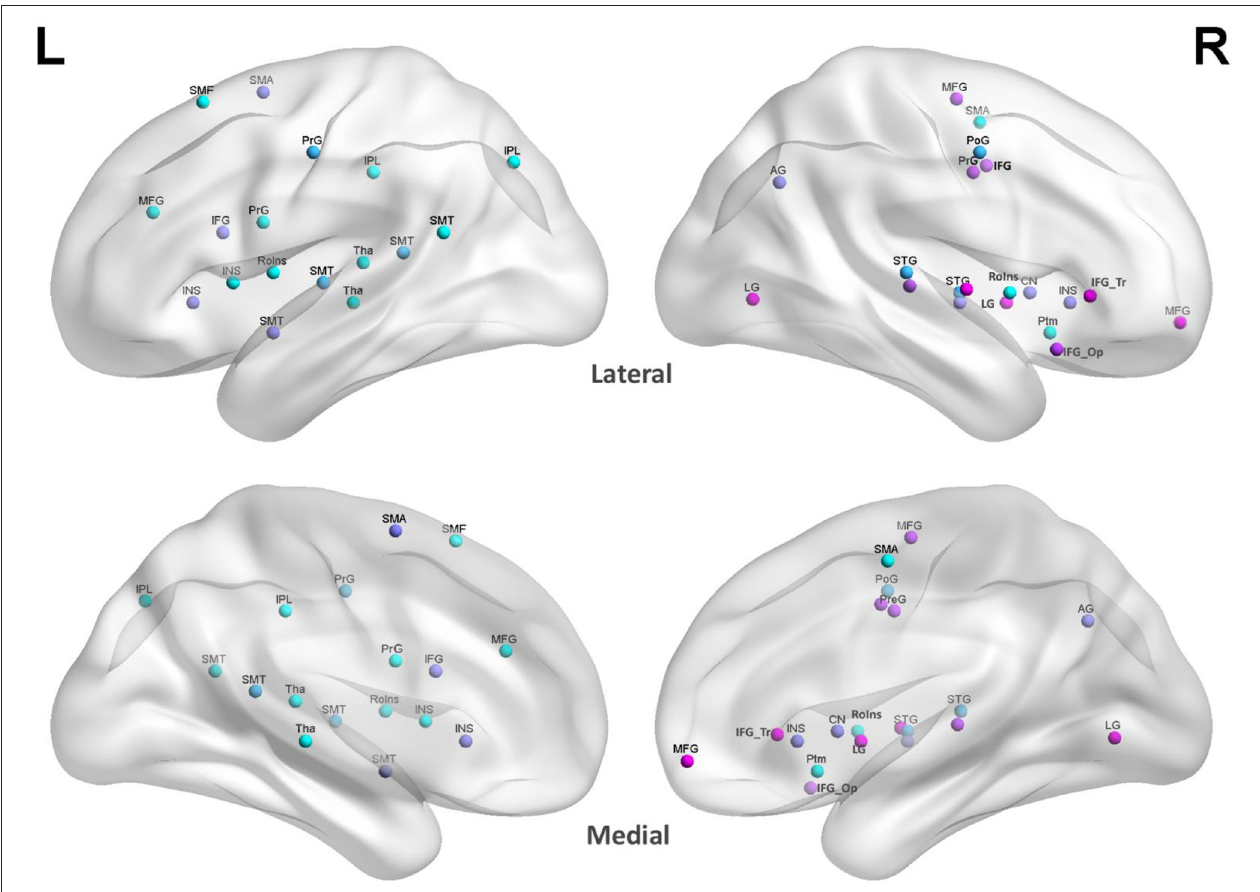
FIGURE 2 | ROI in MIT-supported studies. The site colors were randomly generated to distinguish different ROI regions at the same site to prevent color overlap. L, left hemisphere; R, right hemisphere; Lateral, lateral cerebral hemisphere; Medial, medial cerebral hemisphere; SMT, superior and middle temporal gyrus; SMA, supplementary motor area; SMF, superior and middle frontal gyrus; PrG, pre-central gyrus; PoG, post-central gyrus; IPL, inferior parietal lobule; IFG, inferior frontal gyrus; INS, insula; MFG, middle frontal gyrus; RoIns, rolandic operculum insula; Tha, thalamus; LG, lingual gyrus; AG, angular gyrus; LN, lentiform nucleus; IFG_Tr, inferior frontal gyrus pars triangularis; IFG_Op, inferior frontal gyrus pars